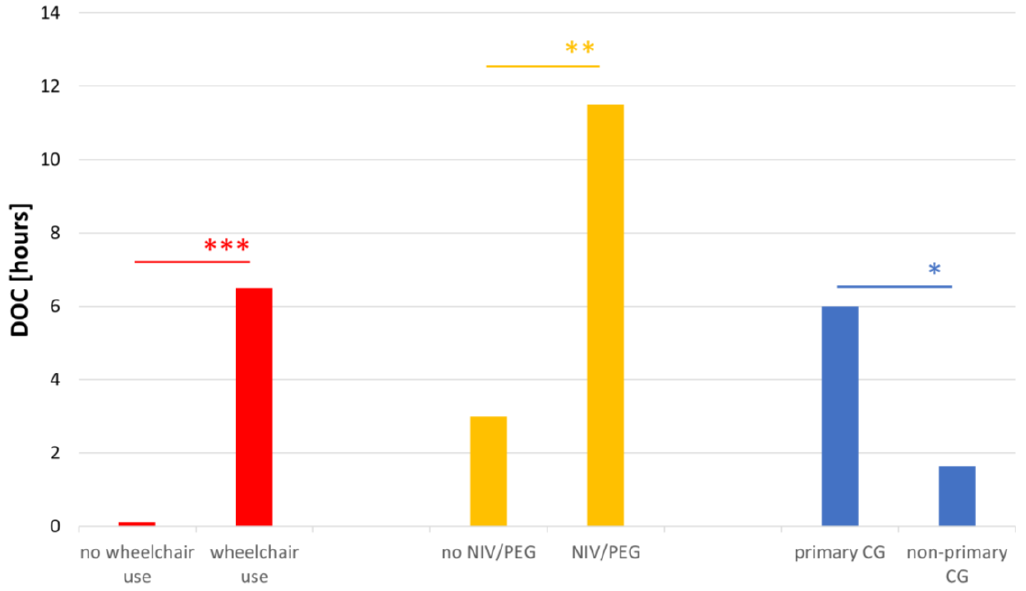
Figure 2. Association of the DOC with patients’ characteristics. Similarly to CGB, a higher DOC was associated with wheelchair use, as well as the use of NIV and PEG. Further, primary CGs had a higher DOC compared to non-primary CGs ( p = 0.036, n = 49). Abbreviations: CG = caregiver; CGB = caregiver burden; DOC = duration of care; NIV = non-invasive ventilation; PEG = Percutaneous Endoscopic Gastrostomy; ZBI = Zarit Burden Interview * p ≤ 0.05; ** p ≤ 0.01; *** p ≤ 0.001.